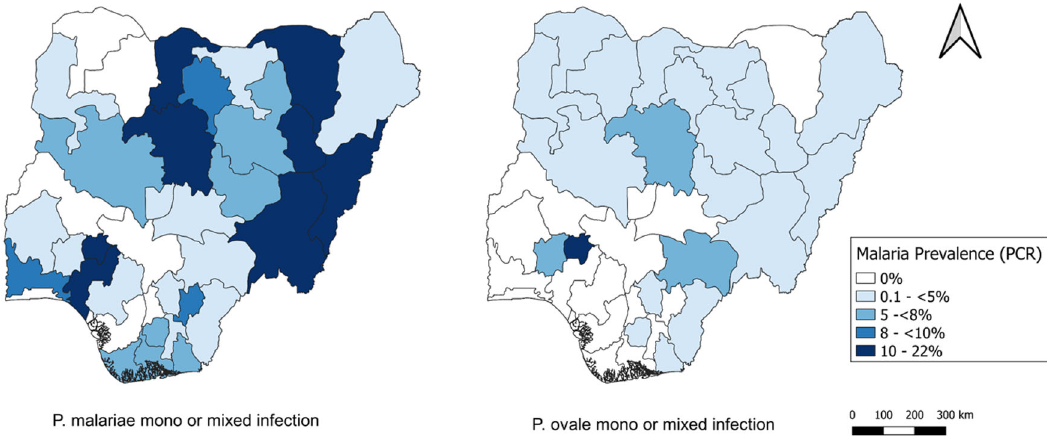
Fig.2|Estimatedprevalenceof P.malariae and P.ovale infectionsbyNigerianstate:2018. Presenceof Plasmodium infectiondeterminedbyPCRassays.Panelsshown for P. malariae on left and P. ovale on right, with darker shading indicating higher estimated proportions of children infected with either of these two